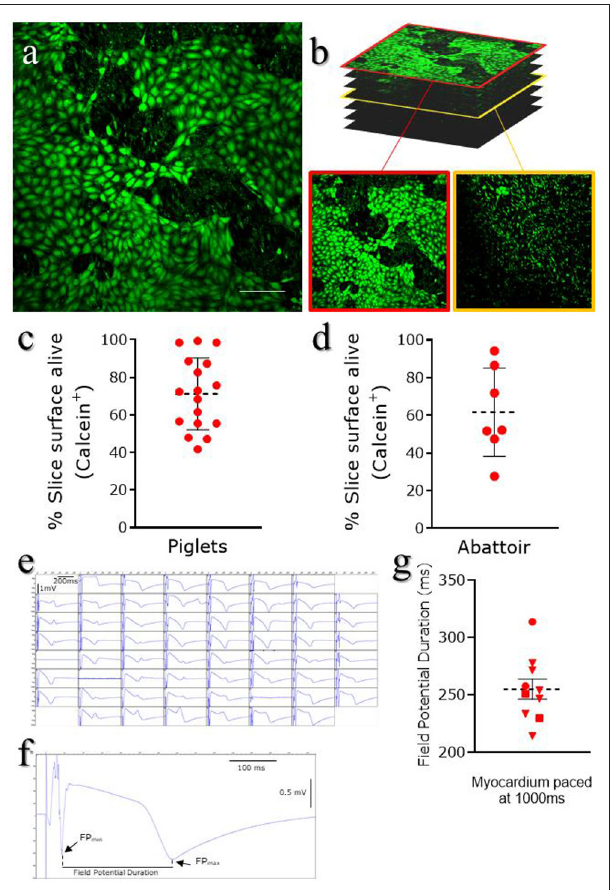
FIGURE 4 | Epicardial slices viability. Viability was assessed using Calcein AM live staining. Live cells are stained green. (a) Representative image of live staining of an epicardial slice imaged using confocal microscopy. Scale bar, 100 µ m. (b) Representative images of Z-stack confocal acquisition of live/dead staining of epicardial slice, showing epicardial cells monolayer on the surface of the slice (red outline) and underlying fibroblasts/myocardium (yellow outline). (c) Quantification of alive area of the surface of piglet slices ( Mean and SEM : 71.21 ± 4.61%; N of slices = 17/ N of Pigs = 10) and (d) abattoir-derived slices ( Mean and SEM : 61.65 ± 8.88%; N of slices = 7/ N of Pigs = 4). (e) Representative field potential traces recorded from cardiomyocytes within the epicardial slices and (f,g) field potential duration, measured as the time between the depolarisation peak (FP MIN ) and the repolarization peak (FP MAX ) ( Mean and SEM was 254.87 ± 8.86ms; N of slices = 10/ N of Pigs = 3).